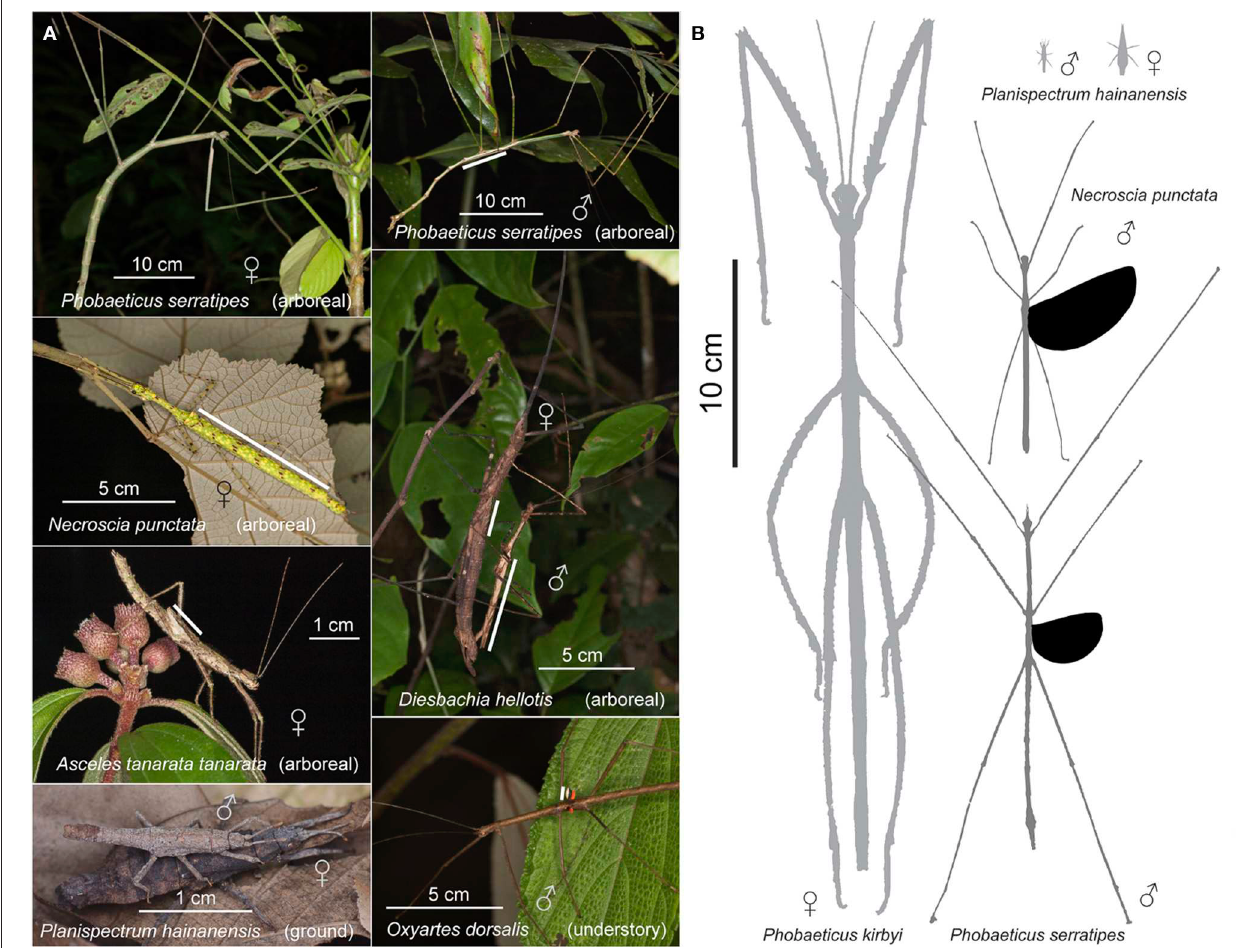
FIGURE 1 | Diversity of flight morphology in stick insects as shown by variation in wing and body size. (A) Examples of stick insects with different sized wings; white line segments indicate hindwing length in winged taxa. (B) Spectrum of interspecific variation in body and relative wing size for representative species (photo of Planispectrum hainanensis courtesy of Chao